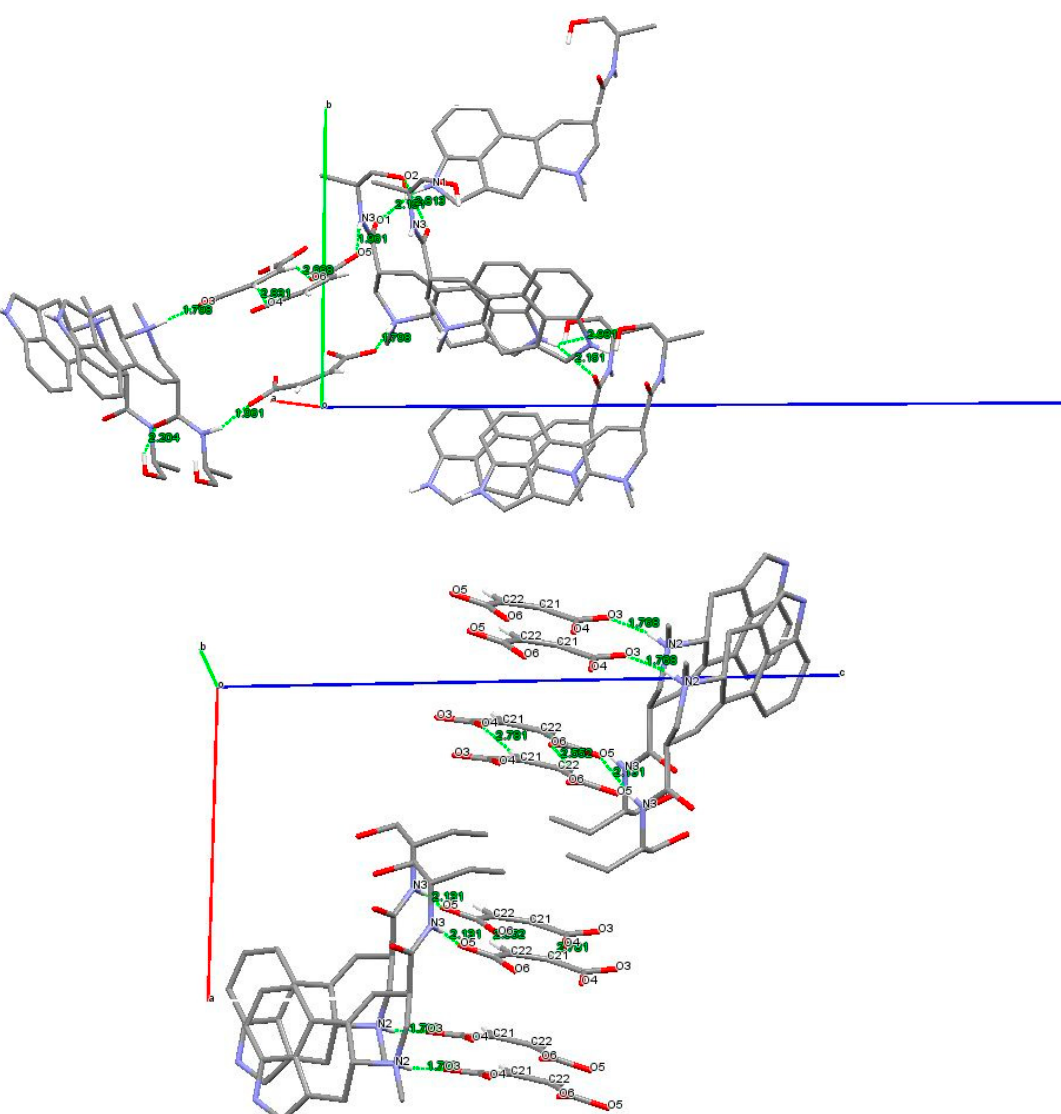
Figure 5. The dashed lines show the intermolecular contacts of 6 ( above ), viewed about along the a -axis, and of 7 ( below ) , viewed about along the b -axis (only the hydrogens involved in the interactions are shown).